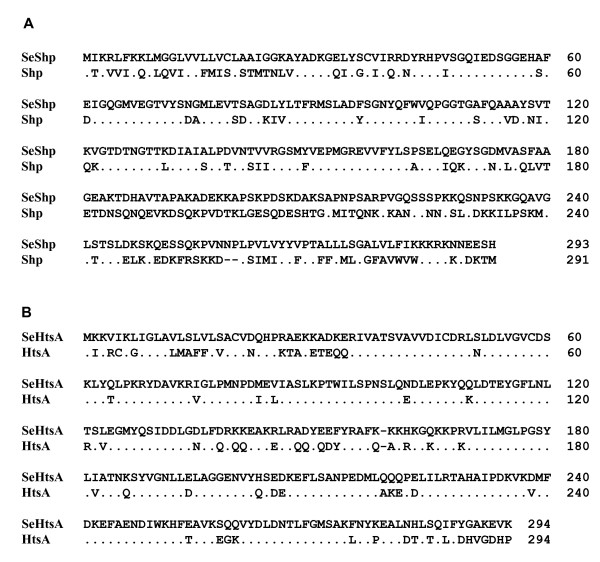
Amino acid sequence alignments of S. pyogenes Shp and S. equi SeShp (A) and SeHtsA and HtsA (B). Amino acid residues of each S. pyogenes protein identical to those of the corresponding S. equi protein (.) and gaps introduced to maximize alignment (-) are indicated.